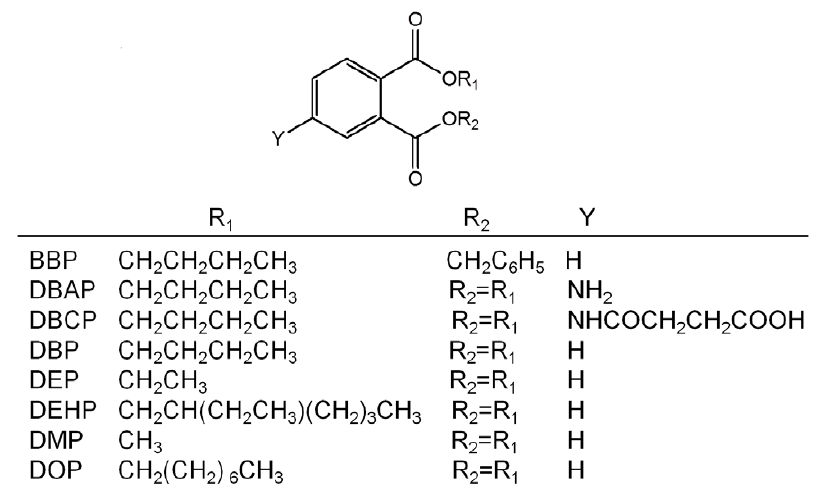
Figure 1. Structures of DBP and analogues.